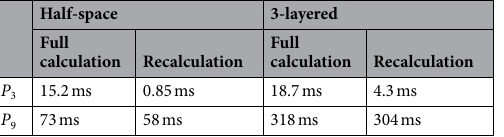
Table 1. Calculation times for the steady-state spatial domain RTE solution in double precision for 2001 spatial